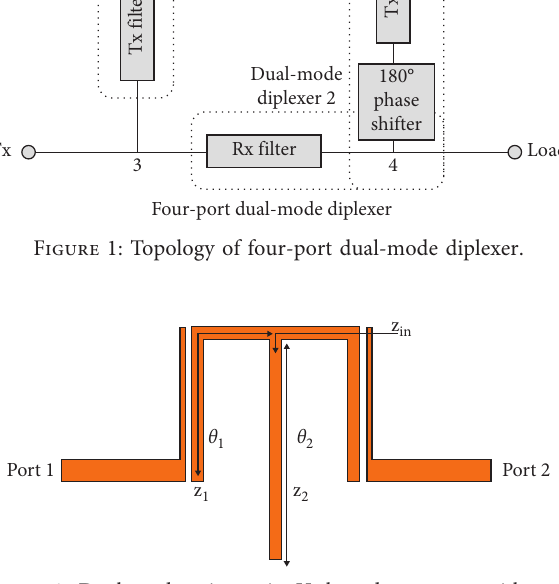
Figure 2: Dual-mode microstrip U -shaped resonator with open stub.